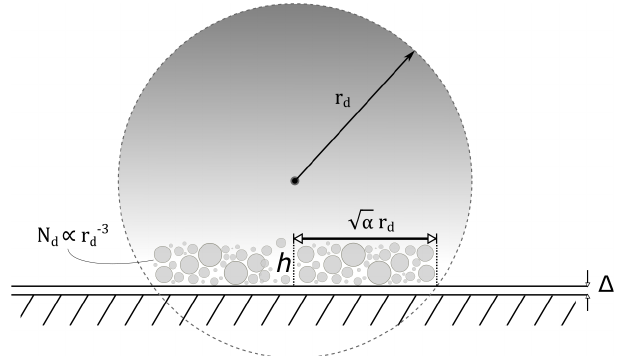
Figure 1. Contact geometry for the charging model of capacitive contact charging. An incoming grain of size above ∼ 10nm can fragment into a distribution of particles (fragments) that can fur- thermore deform and interact with the contact surface in a similar manner to the incoming main grain. The d subscript denotes dust here.